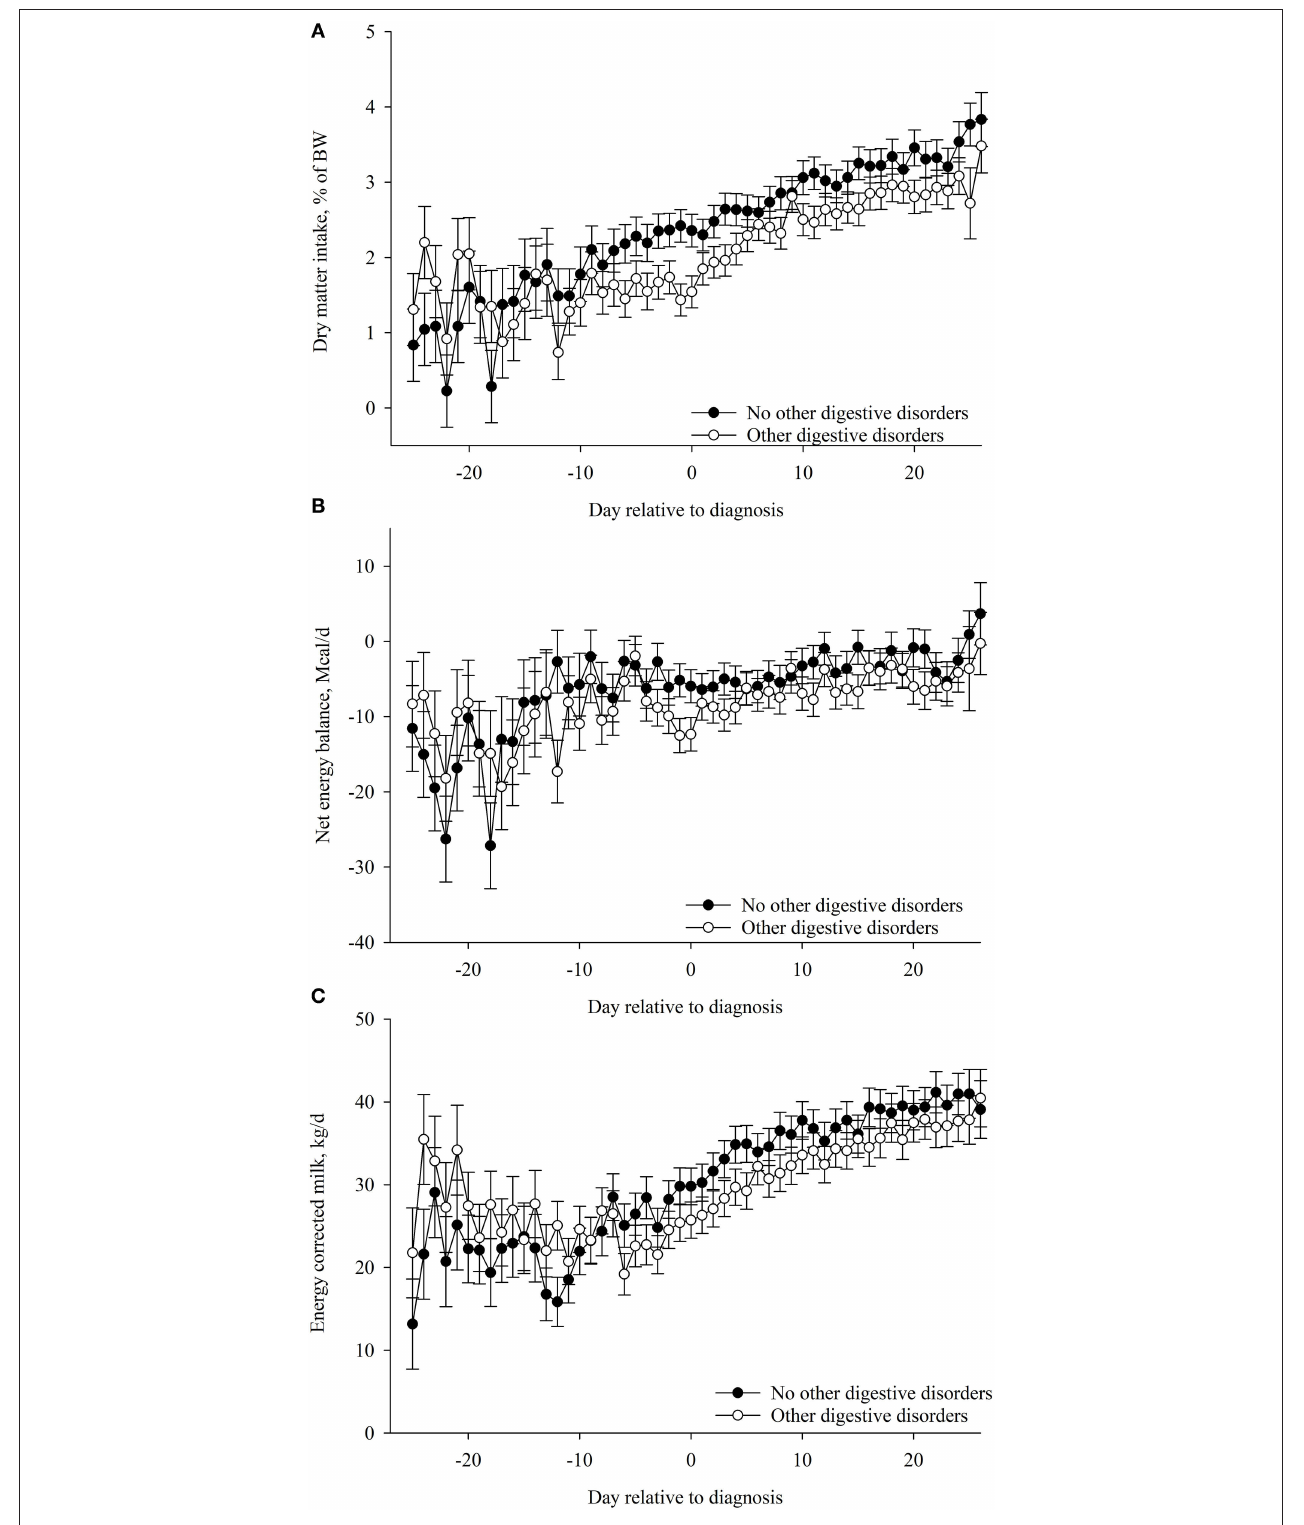
FIGURE 7 | Association of other digestive disorders postpartum ( n = 31) with (A) dry matter intake (DMI, %BW), (B) net energy balance (EB, Mcal/day), and (C) energy-corrected milk (ECM, kg/day) during the postpartum period (from − 25to 25 days relative to diagnosis). Values are least square means ± SEM. Postpartum DMI (%BW): other digestive disorders, p = 0.04; day relative to parturition, p < 0.01; and the interaction between other digestive disorders and day, p = 0.37. Postpartum EB: other digestive disorders, p = 0.40; day relative to parturition, p < 0.01; and the interaction between other digestive disorders and day, p = 0.53. ECM: other digestive disorders, p = 0.57; day relative to parturition, p < 0.01; and the interaction between other digestive disorders and day, p = 0.96.* p ≤ 0.05.